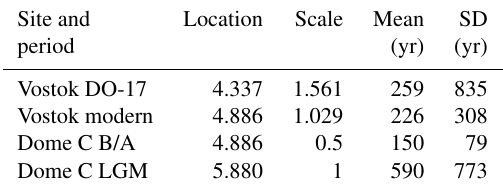
Table 2. Parameters defining the lognormal distributions used as GADs for Vostok DO-17 (this study), lognormal fit to modern Vos- tok (Witrant et al., 2012), Dome C during the Bølling–Allerød (Dome C B/A; Köhler et al., 2015), and Dome C during the Last Glacial Maximum (Dome C LGM; Köhler et al., 2011). Location and scale respectively refer to the parameters µ and σ used in Eq. (1) in Köhler et al. (2011). SD stands for standard